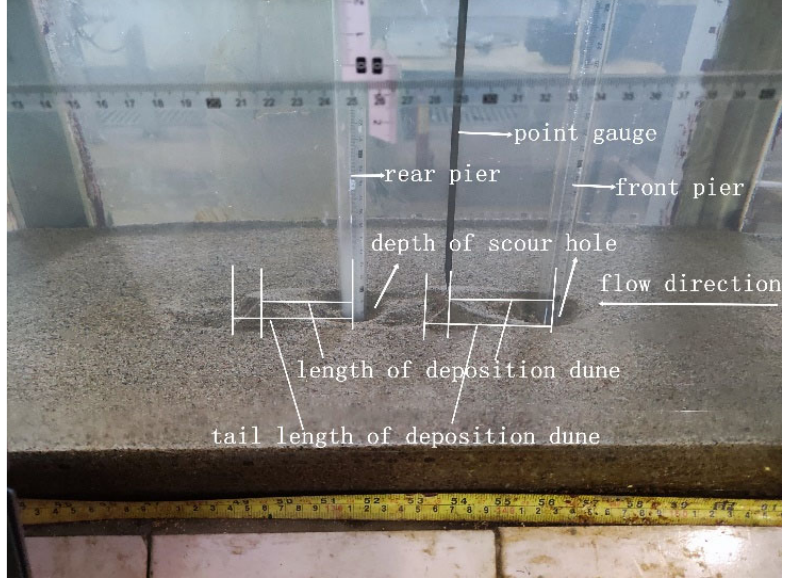
Figure 2. Measurement using a point gauge. Table 1. Experimental conditions and results.